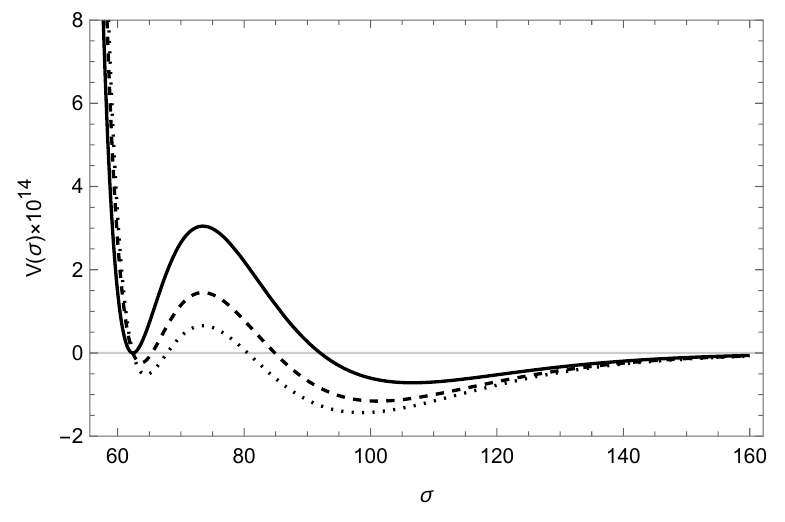
Figure 1 . The KL potentials for A 1 = 1 , A 2 = − 1 . 03 , a 1 = 2 π/ 100 , a 2 = 2 π/ 99 and W 0 = − (1 + δ ) P A j e − a j σ 0 with σ 0 given by equation (2.9). The thick line corresponds to δ = 0 , while j δ = 0 . 2 and 0 . 3 corresponds to the dashed and dotted lines,